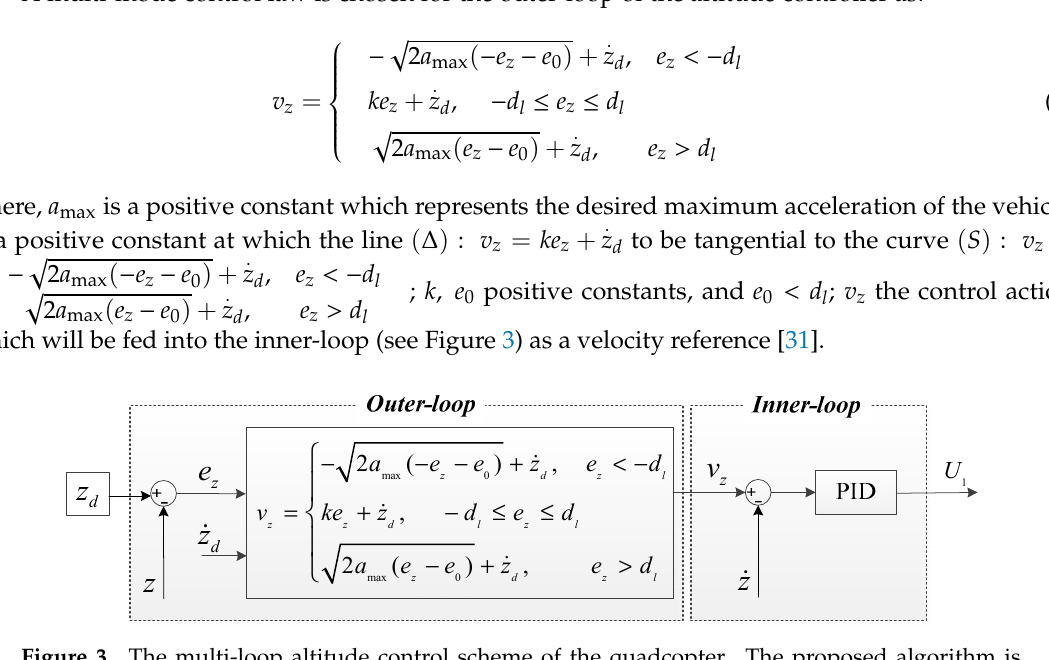
Figure 3. The multi-loop altitude control scheme of the quadcopter. The proposed algorithm is implemented in the outer-loop while a PID controller is used in the inner-loop.